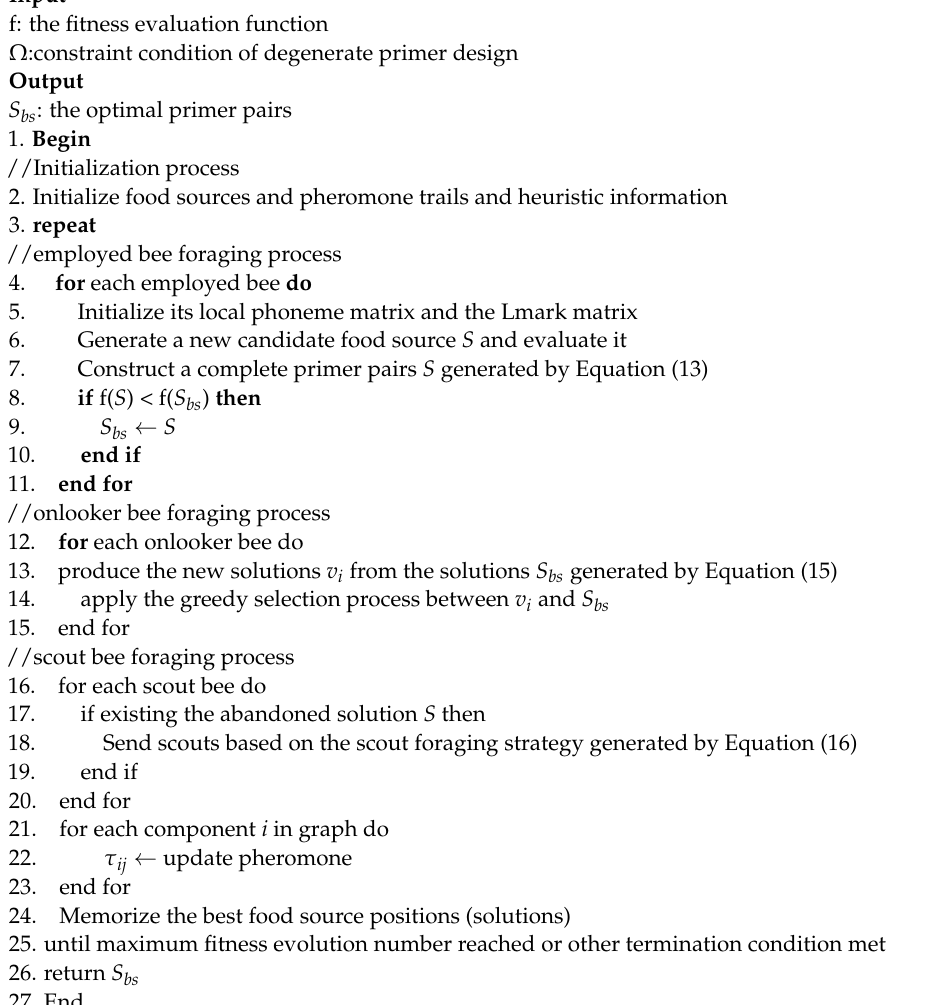
Algorithm 1. DPD-HABC Algorithm for Degenerate Primer